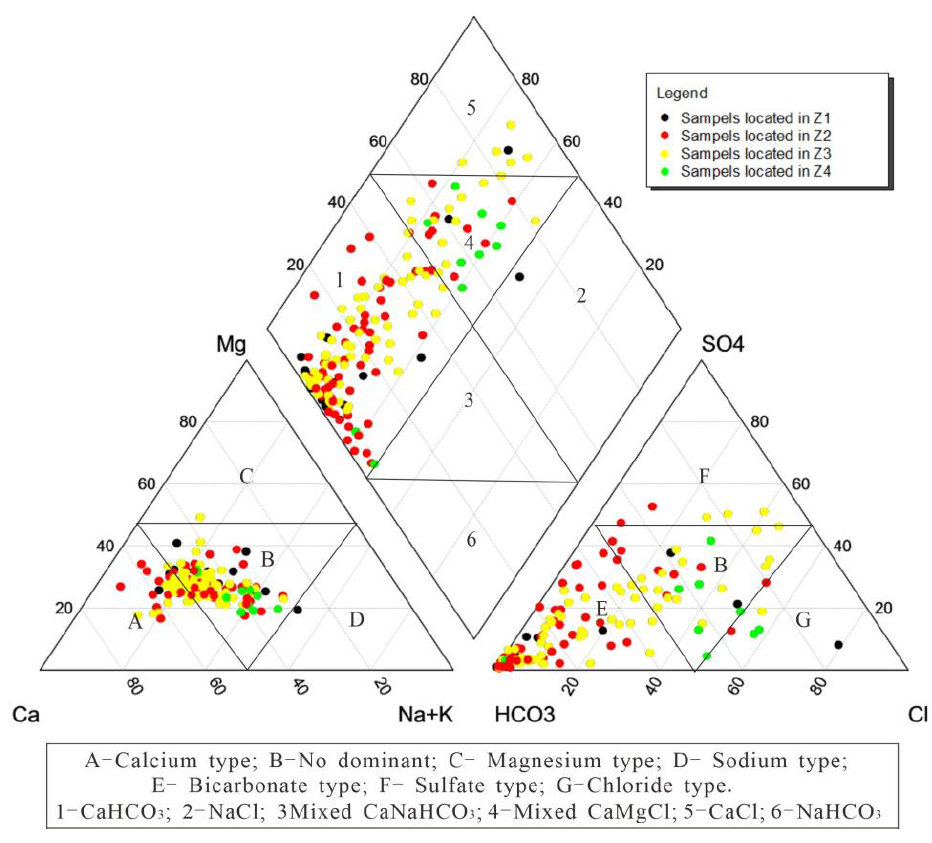
Figure 3. Piper third-line diagram of groundwater samples in MXP.